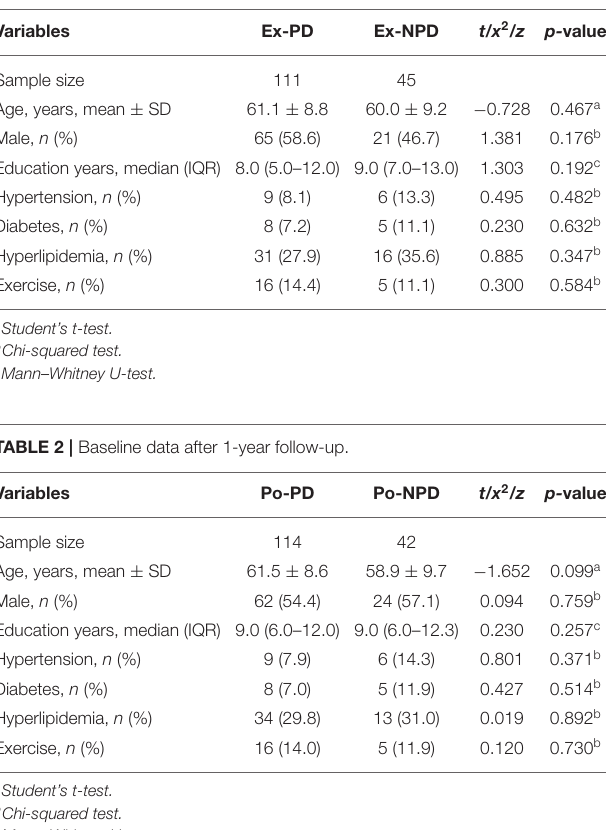
TABLE 1 | Baseline data of newly diagnosed patients.